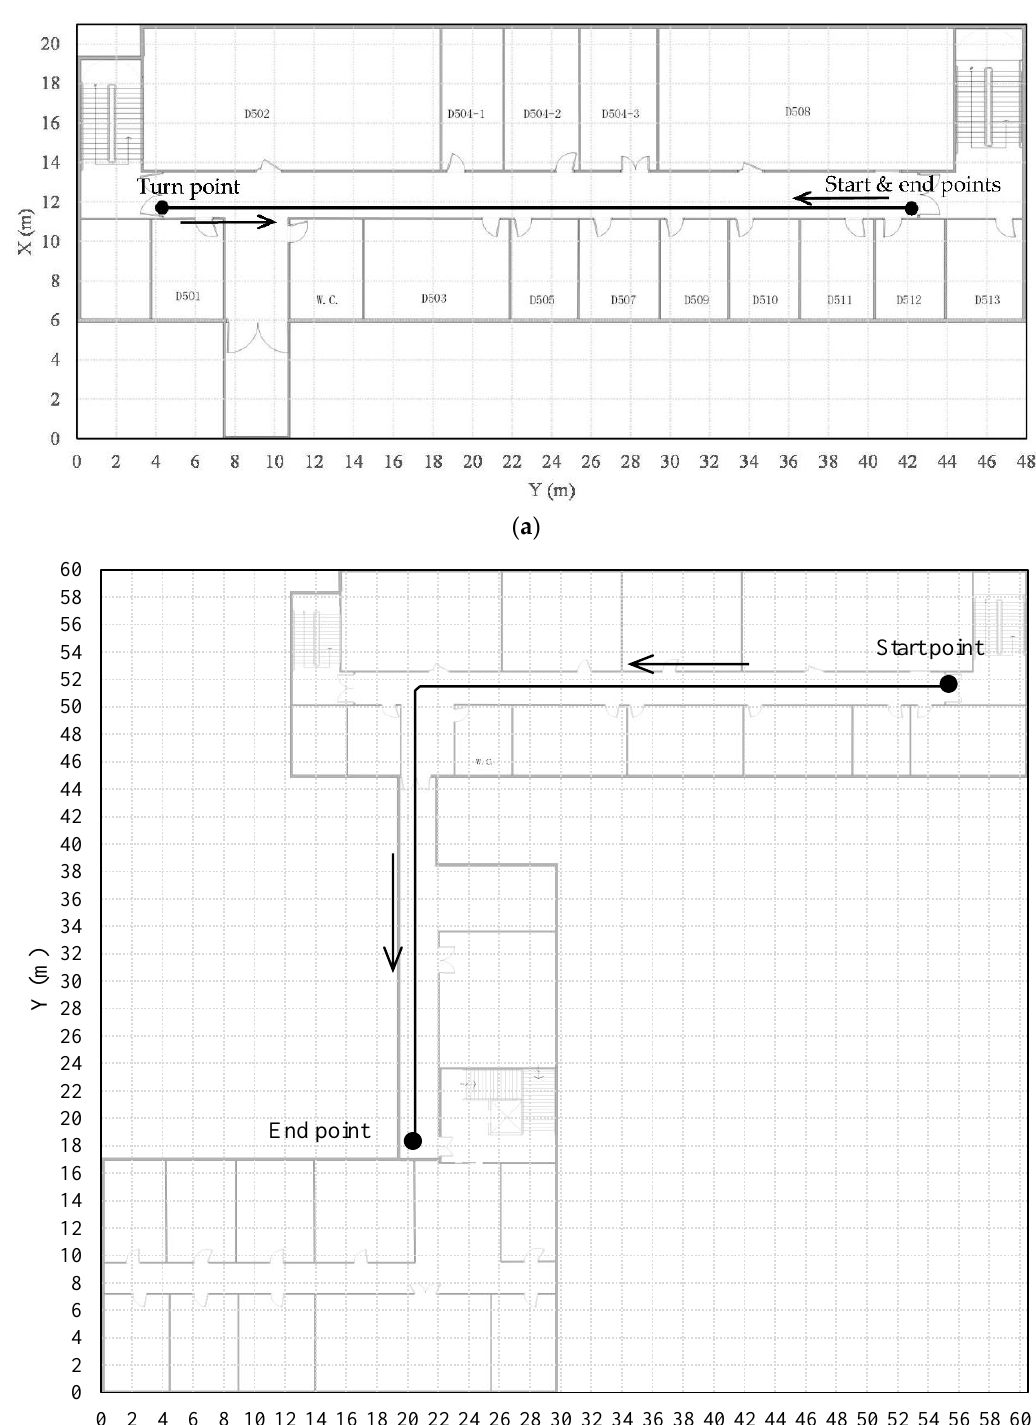
Figure 3. Floor plans of the sites for dynamic tests, ( a ) the first site, ( b ) the second